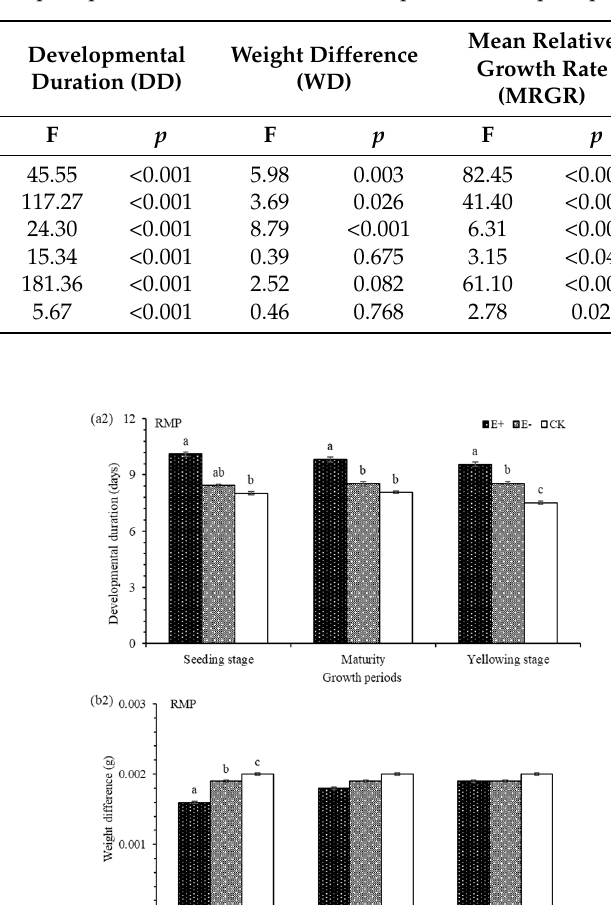
Table 4. Two-way ANOVA for the effects of growth periods (G) and treatments (T) on the biological parameters of green color morphs of pea aphids (GMP) and red color morphs (RMP) of pea aphids.